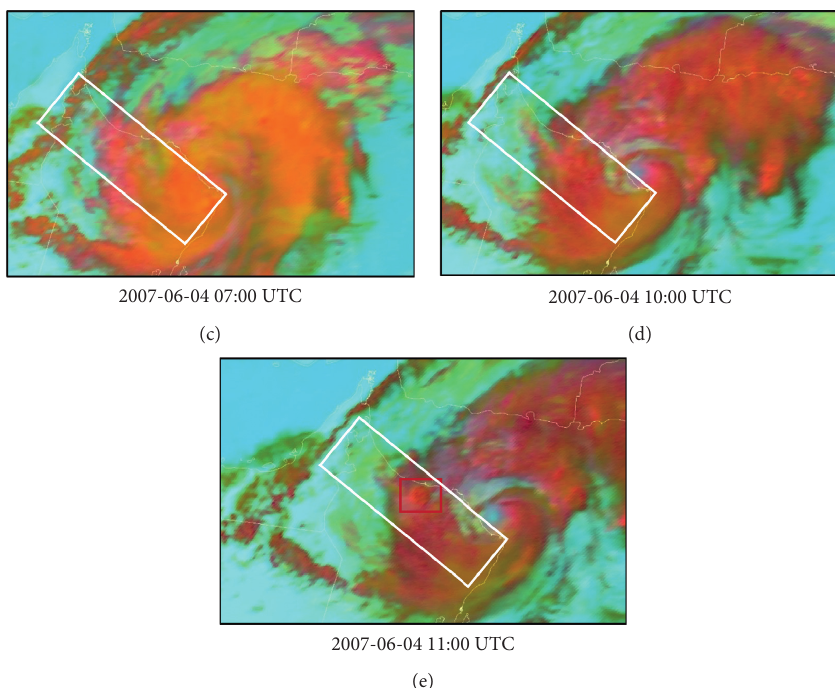
Figure 12: Sequence of day microphysics RGB images on 3 and 4 June 2010. The color scheme is useful to detect optically thick clouds with small ice particles on top (orange), thin clouds with small ice particles (light green), stratocumulus (violet), and water clouds